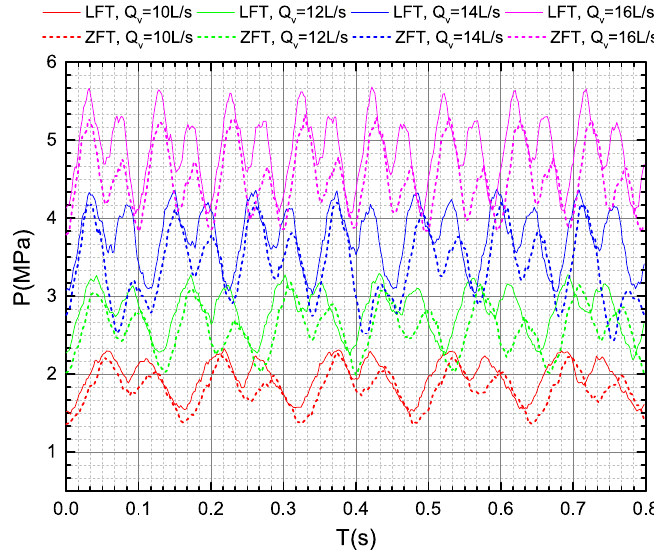
Figure 6. Variation of pressure drop P with time T for different supply volume flow rates Q V .